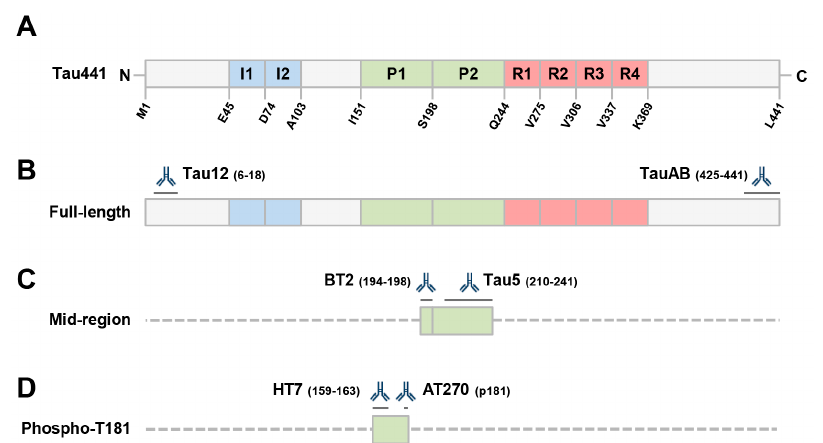
Figure 1. Schematic depicting the longest isoform of human tau (441), the antibodies employed and the tau fragment(s) recognized by immunoassays used in this study. ( A ) Domain structure of tau, including the 2 N-terminal inserts (I1 and I2), the proline-rich domain (P1 and P2), and the microtube-binding repeat domain (R1 to R4), which is required for tau aggregation. ( B ) Both our full-length ELISA and Simoa assays employ Tau12, a mAb to the extreme N-terminus of tau, and TauAB, a mAb to the extreme C-terminus. ( C ) Our mid-region assay employs mAbs BT2 and Tau5 which recognize epitopes in the proline-rich domain. This assay is highly similar to those used in clinical research. ( D ) The Innotest phospho-tau kit (from Fujirebio) employs 2 mid-region directed mAbs; HT7, which recognizes an epitope spanning residues 159–163, and AT270, a mAb specific for phosphorylated threonine 181. Epitopes for the antibodies are indicated by dark grey lines. Sequences of minimal predicted length recognized by a given ELISA are shown in filled boxes and other potentially detectable forms of tau are indicated with dashed lines.